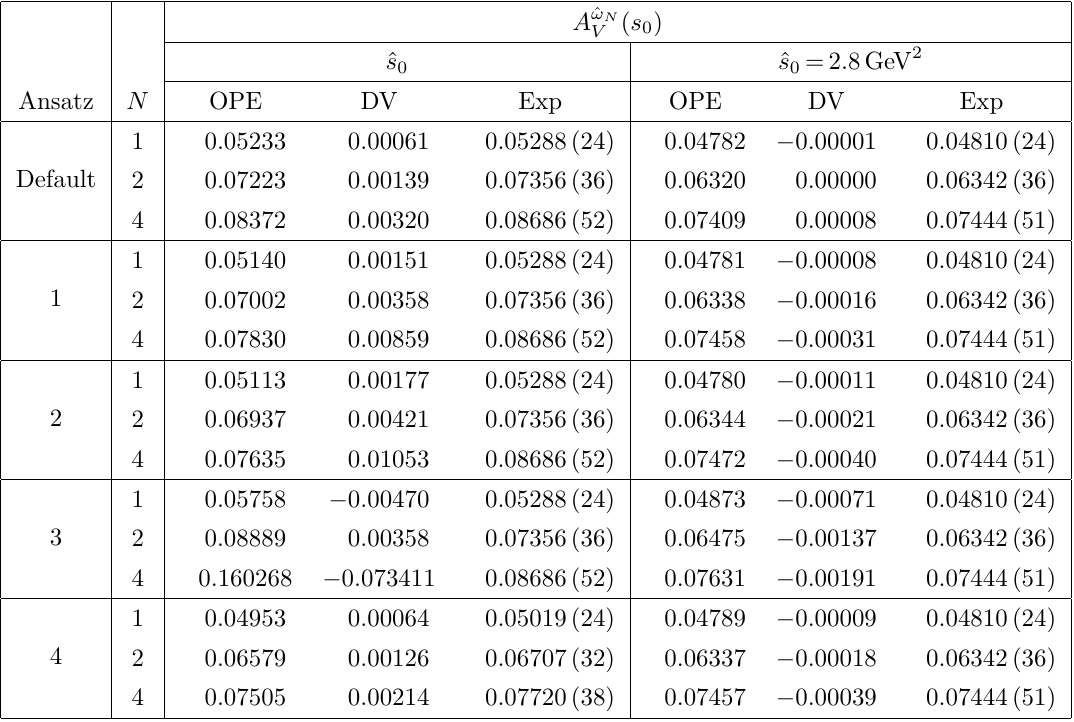
Table 11 . Separate values of the OPE and DV contributions to the moments of the vector dis- tribution A ˆ ω N ( s ) , obtained with the different ansatz variations, together with their experimental 0 V values, for the pinched weights ˆ ω ( x ) = 1 − x N N